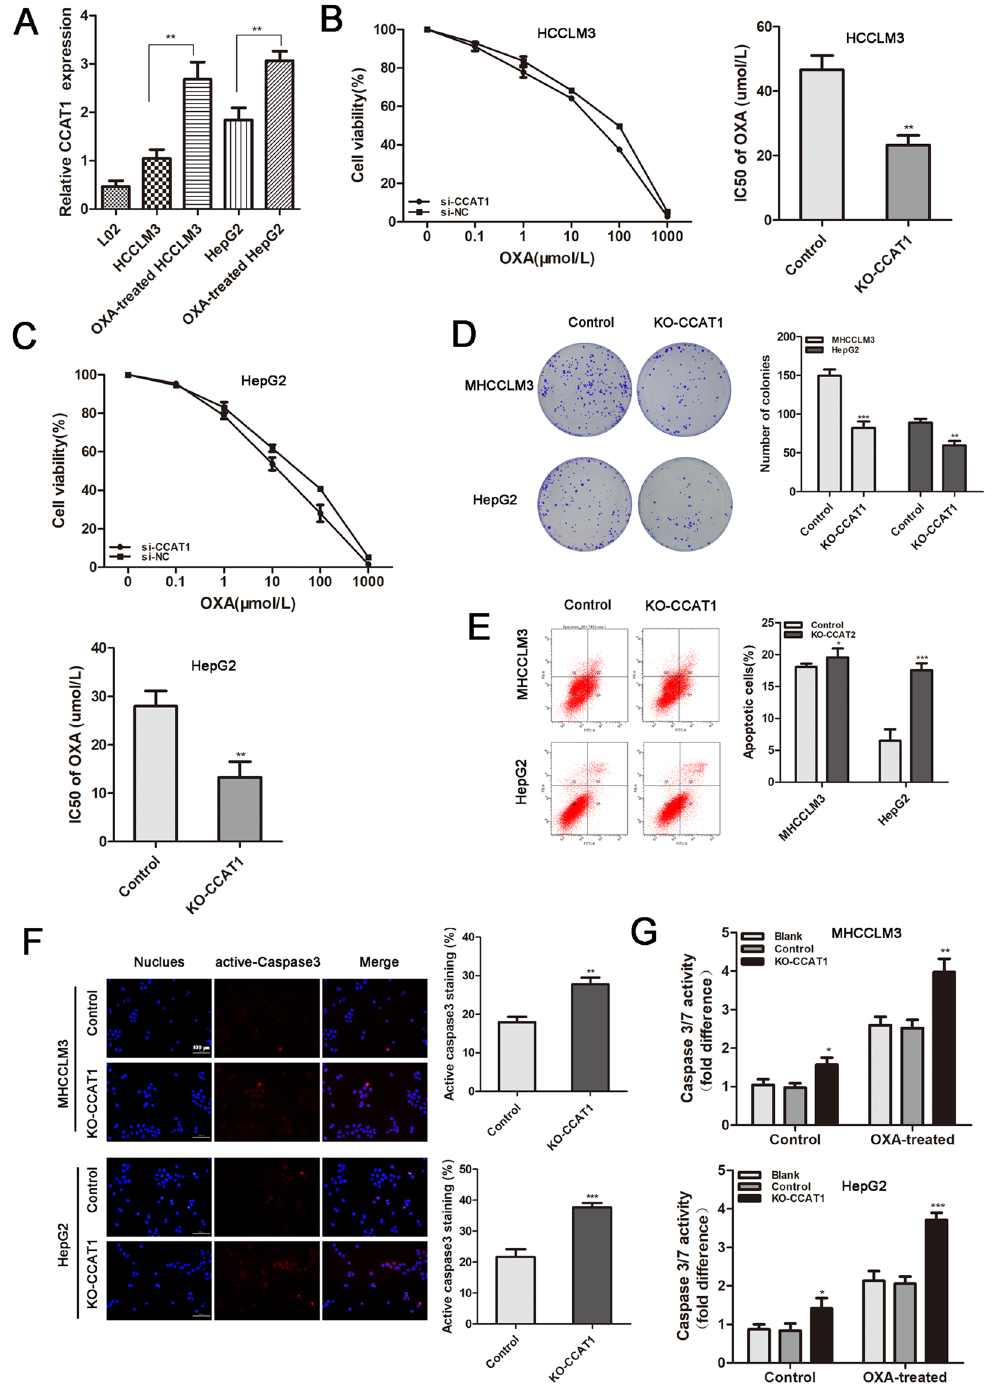
Figure 1. CCAT1 enhanced HCC resistance to oxaliplatin in vitro. ( A ) HCC cells received OXA treatment for 48 h, the expression of CCAT1 was determined by qRT-PCR. ( B , C ) HCCLM3 and HepG2 HCC cell lines were knocked out of CCAT1 and exposed to increasing concentrations of oxaliplatin from 0.1 to 1 mM for 48 h to determine the IC50 values by CCK-8 assay. (IC50 of HCCLM3 control and KO-CCAT1: 46.56 vs. 23.22 μM; HepG2 control and KO-CCAT1: IC50: 27.98 vs. 13.28 μM, p < 0.01 respectively). ( D ) The colony formation assay showed that the numbers of colonies were reduced when CCAT1 was knocked out. ( E ) Significantly increased proportion of apoptotic cells by in the KO-CCAT1 groups. ( F ) Significantly increased caspase-3 activation following knock out of CCAT1, indicated by red fluorescence staining ( p < 0.01). ( G ) Caspase-3 and caspase-7 activities were measured by Caspase-Glo® 3/7 Assay ( p <